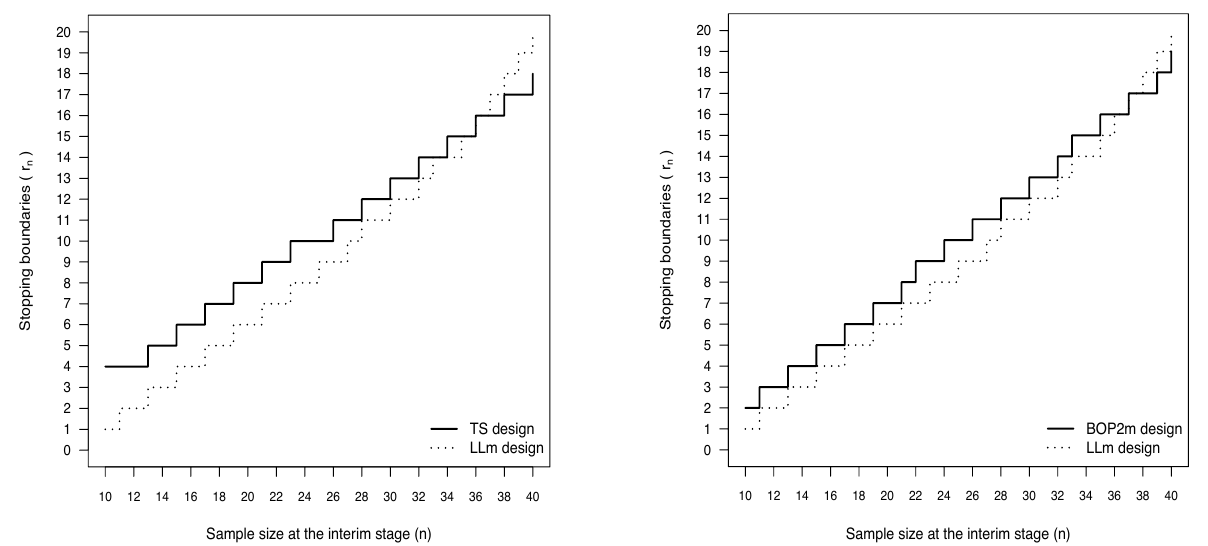
Figure 3. Comparison of stopping boundaries (TS vs. LLm ( left panel ) and BOP2m vs LLm ( right panel )), when N = 40, N min = 10, δ = 0.1, π ( p S ) = beta ( p S ;63,94 ) , π ( p E ) = beta ( p E ;1.4,1.6 ) and the nominal level for the type I error rate is 0.1.